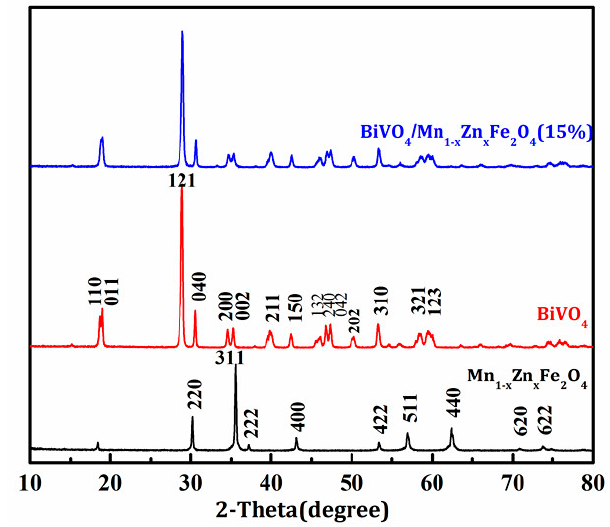
Figure 1. XRD (X-ray Diffractometer) patterns of the prepared samples.